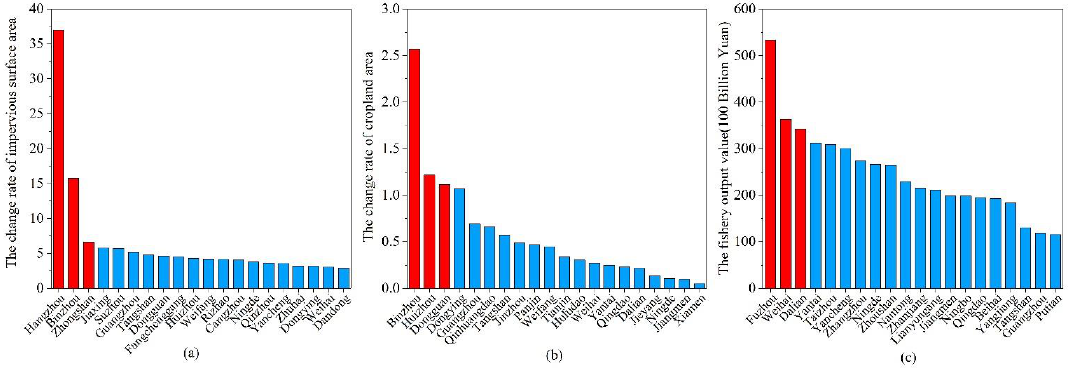
Figure 1. Top 20 rankings of different types of change in cities in China: ( a ) China ’ s coastal cities ranked among the top 20 cities in terms of the change rate of impervious surface area. ( b ) China ’ s coastal cities ranked among the top 20 cities in terms of the change rate of cultivated land area. ( c ) China ’ s coastal cities ranked among the top 20 cities in terms of fishery output value in 2020. The red bars show the top three cities for each indicator.